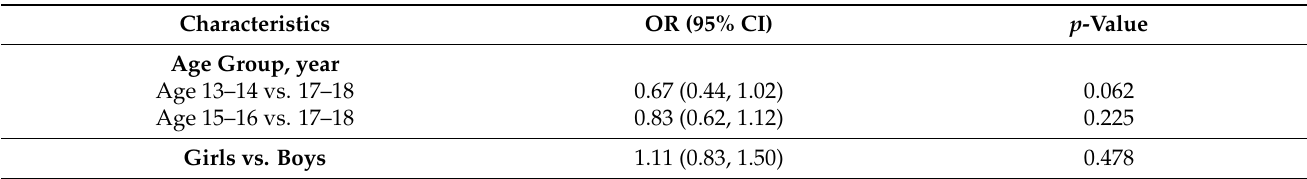
Table 6. Multivariable Adjusted Odds Ratios (95% CI) of Hanging Out with Friends as Location of First ENDS Product Use—Quantitative